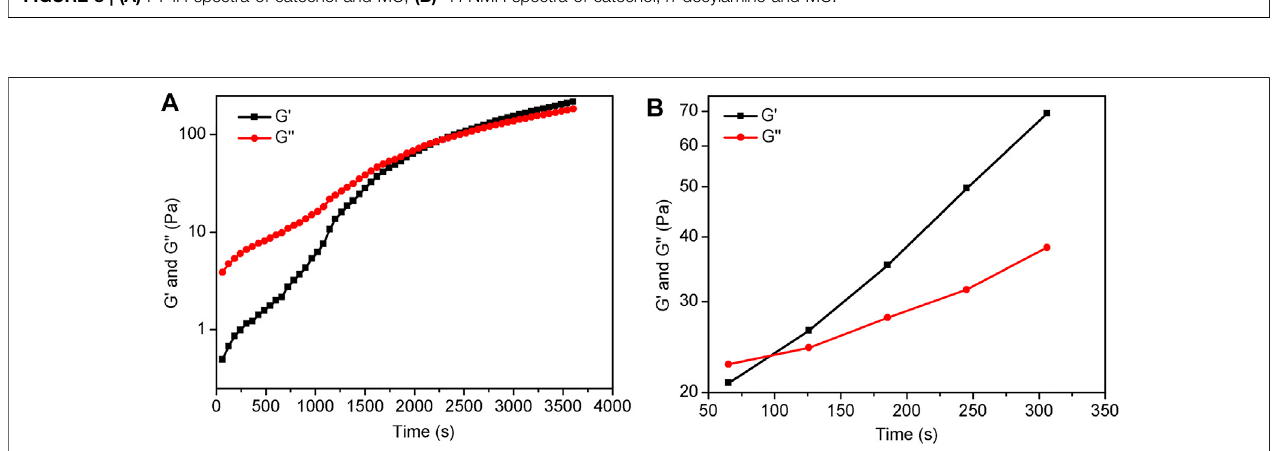
FIGURE 9 | Rheological curves of H-9 (A) and C-13 (B) s.